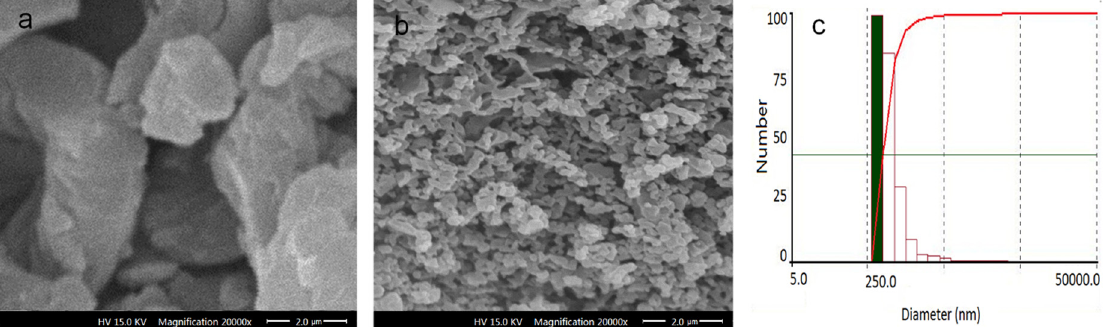
Figure 7. Scanning electron micrographs of ( a ) unprocessed and ( b ) processed spiramycin (spiramycin microparticles are the micronized spiramycin by homogenate-antisolvent precipitation under optimum conditions), and particle size distribution of processed spiramycin under optimized experiment conditions ( c ).